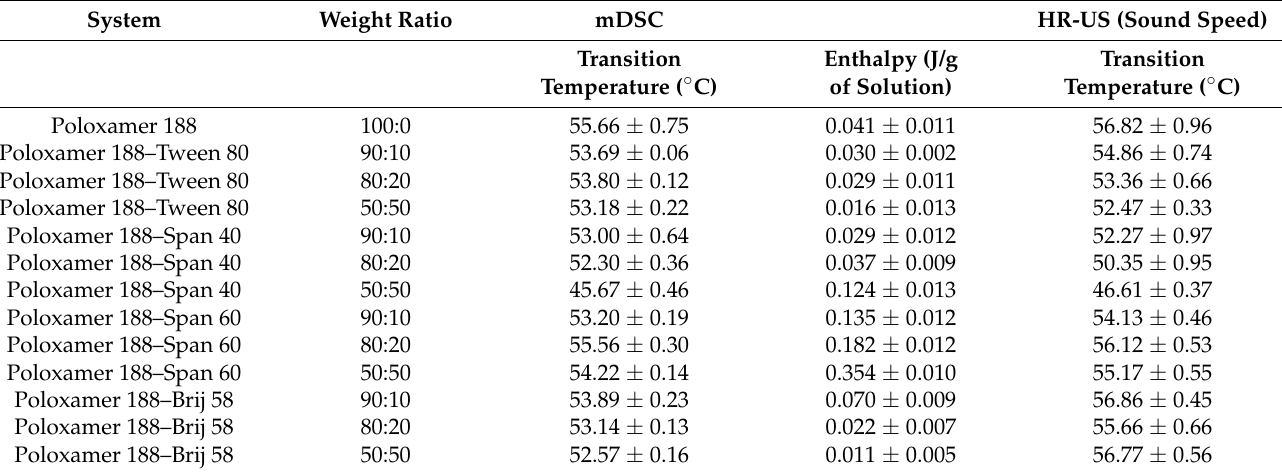
Figure 4. Sound speed vs. temperature for ( A ) Pl 188 (10 mg/mL), ( B ) Pl 188-Tween 80 ® , and ( C ) Pl 188-Brij 58 ® at different weight ratios. Table 3. The thermotropic characteristics of the studied systems.